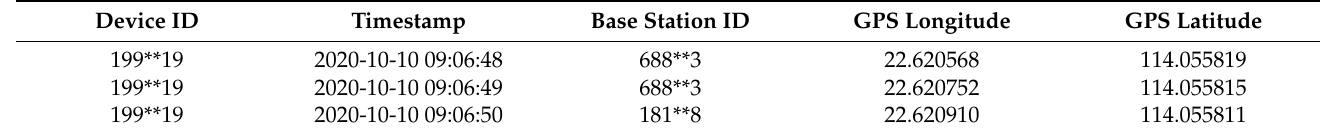
Table 1. Information of the acquired data.